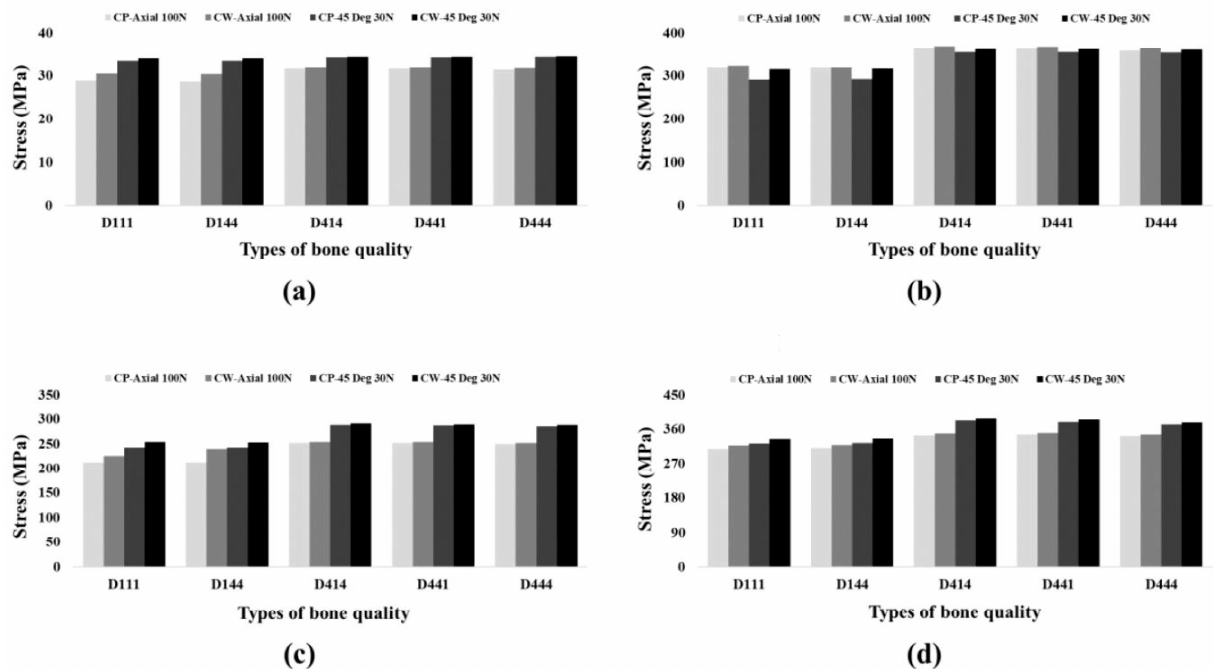
Figure 7. The PVMS of each component for the 5 bone densities and 2 surgical techniques under 100 N axial load and 30 N oblique load. ( a ) PVMS of crown, ( b ) PVMS of abutment, ( c ) PVMS of fixture, and ( d ) PVMS of abutment